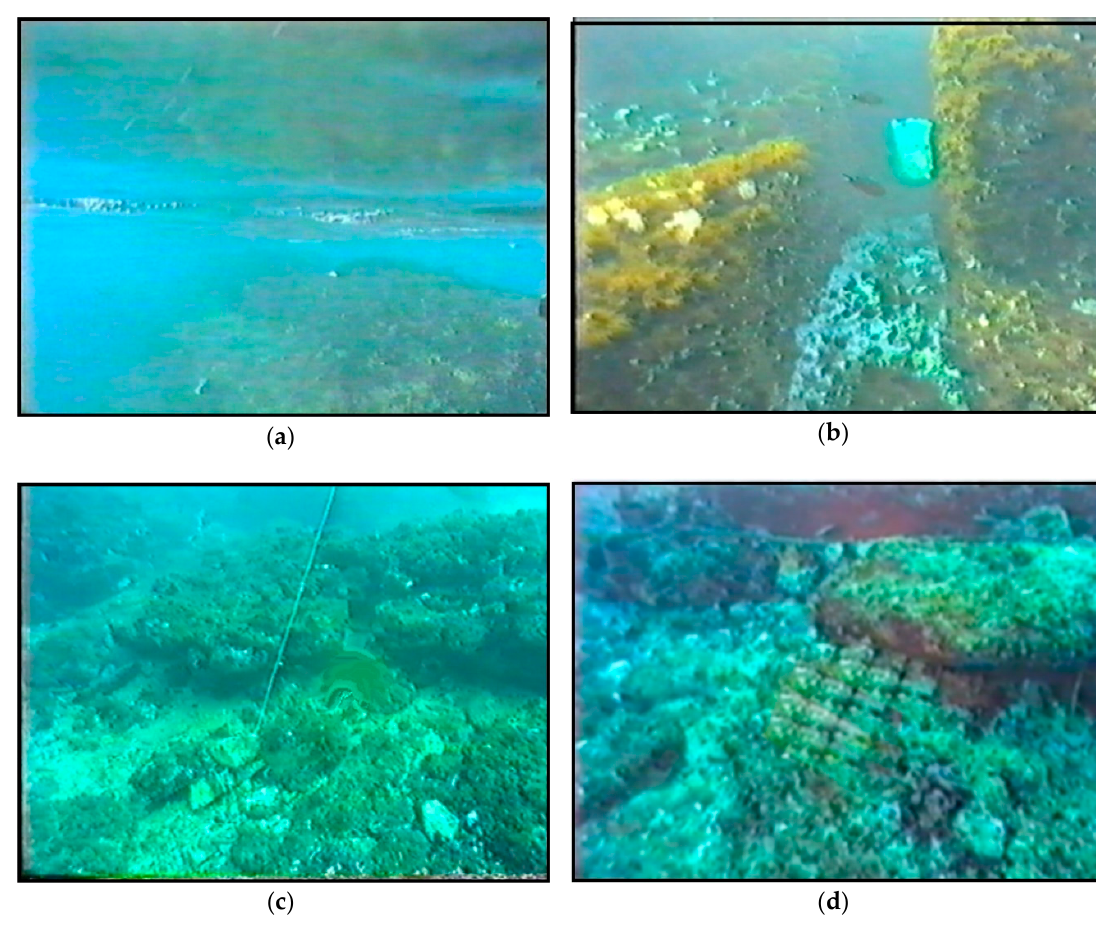
Figure 4. Underwater photos of the direct survey carried out by the Centro Studi Subacquei: ( a ) and ( b ) elongated archaeological structure parallel to Castel dell'Ovo; ( c ) walls in concrete crossed by small rounded holes; ( d ) remains of opus reticulatum.